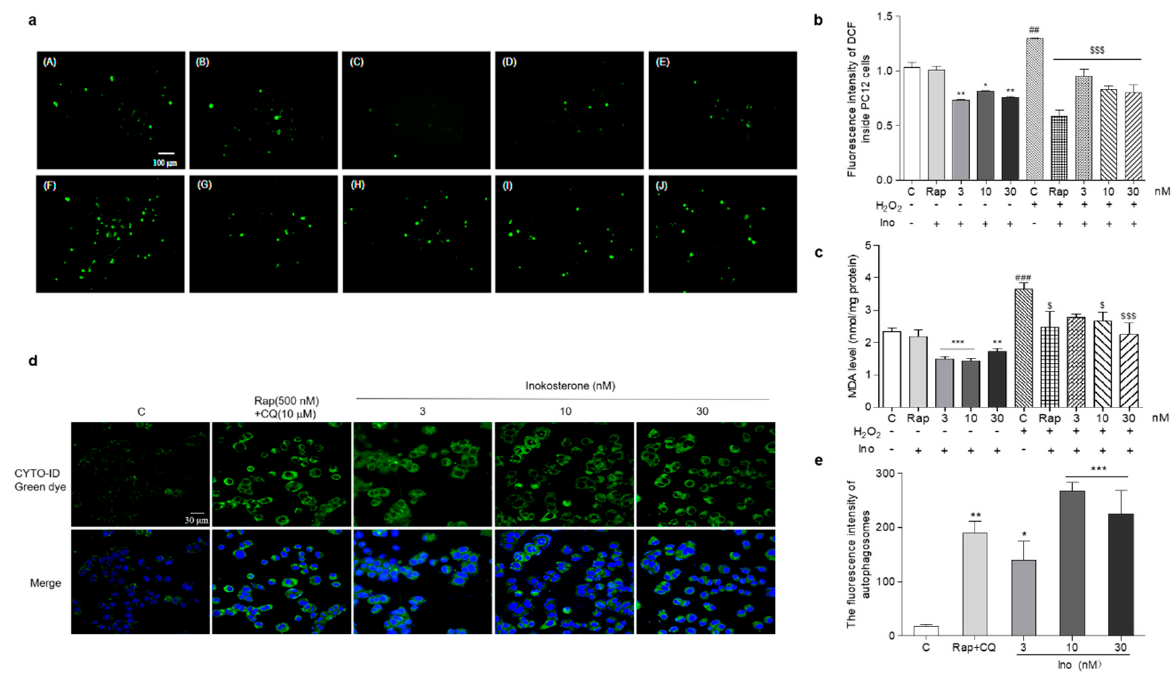
Figure 7. Effects of inokosterone on the ROS, MDA and autophagy of mammal cells. ( a ) Photomicro- graphs of PC12 cells stained with DCFH-DA under a fluorescence microscope. Control (0.1%DMSO) ( A ), Rap (500 nM) ( B ), inokosterone (3 nM) ( C ), inokosterone (10 nM) ( D ), inokosterone (30 nM) ( E ), H 2 O 2 -treated control (0.8 mM) ( F ), H 2 O 2 + Rap (500 nM) ( G ), H 2 O 2 + inokosterone (3 nM) ( H ), H 2 O 2 +inokosterone (10 nM) ( I ), H 2 O 2 + inokosterone (30 nM) ( J ). ( b ) The changes of the ROS level of the PC12 cells after treatment with rapamycin and different doses of inokosterone. ( c ) The changes of the MDA levels of PC12 cells after treatment with rapamycin and inokosterone. ( d ) The changes of the autophagy in PC12 cells induced by rapamycin and inokosterone. ( e ) The digital result of ( d ) with ImageJ software. The experiments were repeated thrice, and the data are presented as the mean ± SEM. *, ** and *** indicate significant differences from the control group at p < 0.05, p < 0.01, and p < 0.001, respectively. ## and ### indicate significant differences between the negative control and the H 2 O 2 -treated control at p < 0.01 and p < 0.001, respectively. $ and $$$ represent significant differences compared with the H 2 O 2 -treated control at p < 0.05 and p < 0.001,